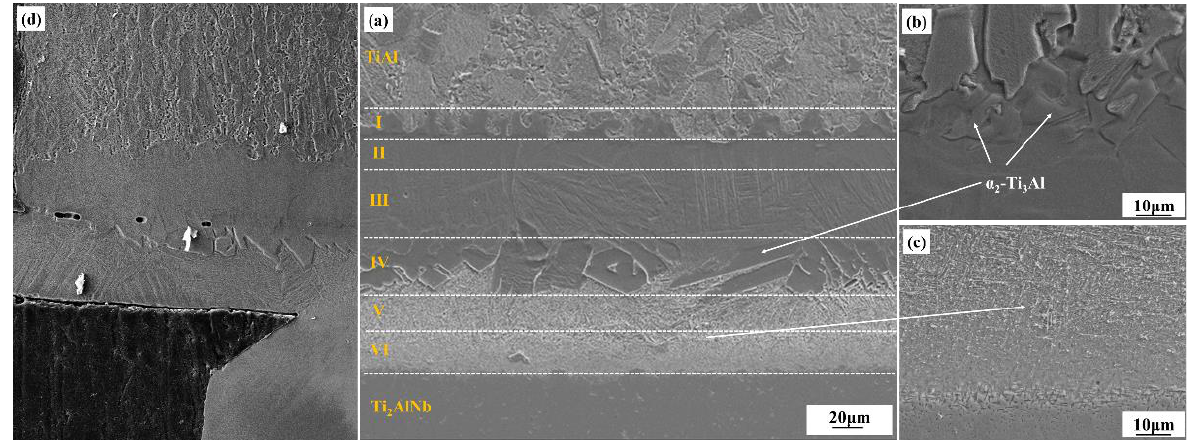
Figure 4. Microstructure of the as-weld joint: ( a ) SEM image of the joint; ( b ) enlarged image of Zone Ⅳ ; ( c ) enlarge image of Zone Ⅵ ; ( d ) cross-section image of the fracture.